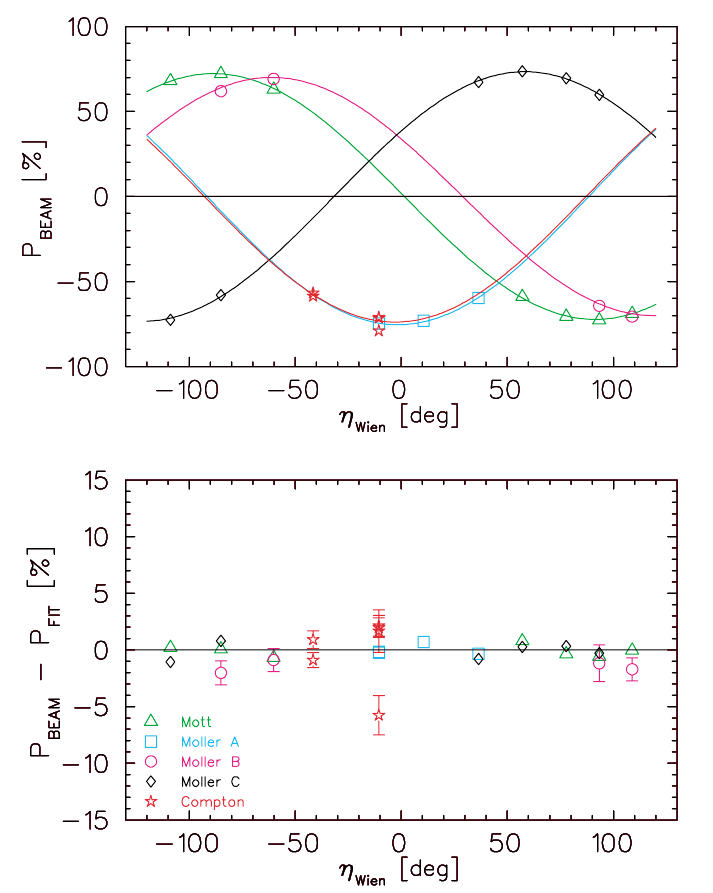
FIG. 10. (Color) Polarimeter data and fit (upper plot) using (cid:12) and data set limited to be within 25% of the maximum polarization. Fit residuals (lower plot) are shown using only statistical uncertainties from polarimeter data. Note: the lower plot legend applies to the upper plot.